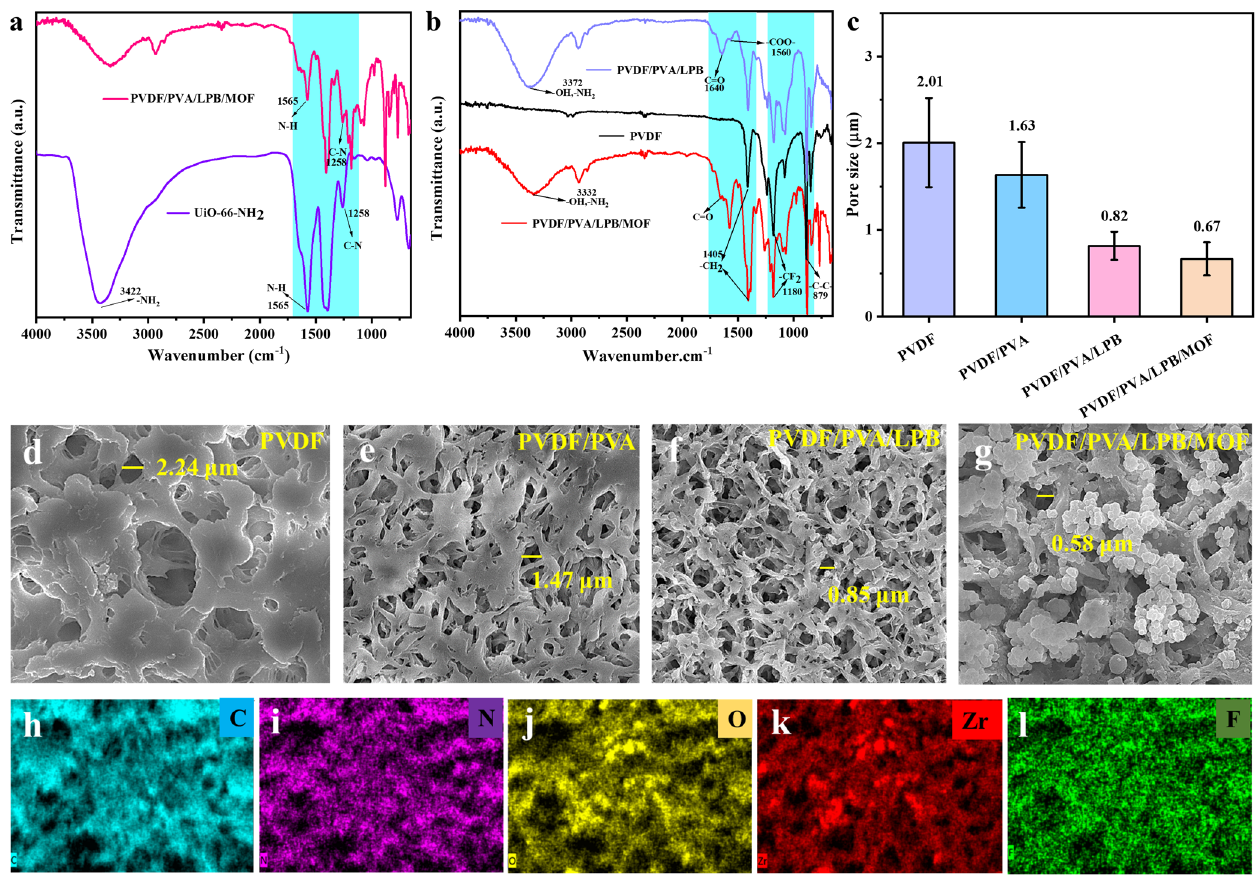
Fig. 2 FT-IR, pore size, and surface morphology of different composite membranes and EDS characterization of PVDF/PVA/LPB/MOF membranes. FTIR spectra of a UiO-66-NH 2 , PVDF/PVA/LPB/MOF and b PVDF/PVA/LPB /MOF, PVDF/PVA/LPB and PVDF membranes. c The average pore size of different membranes (s.d.). The FE-SEM images of d PVDF, e PVDF/PVA, f PVDF/PVA/LPB and g PVDF/PVA/LPB/MOF membranes (scale bar: 2 μ m). EDS elemental mapping of PVDF/PVA /LPB/MOF membranes h Carbon, i Nitrogen, j Oxygen, k Zirconium and l Fluorine (scale bar: 2 μ